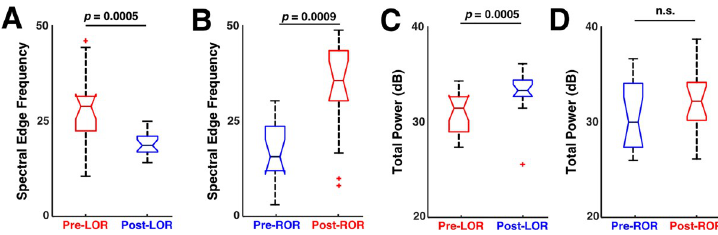
Fig 4. Spectral changes before and after loss and recovery of response. Spectral edge frequency and total power changes that occur in the 20 second clips analyzed before and after loss of response (LOR) and recovery of response (ROR). A) A significant decrease in spectral edge frequency was observed before to after LOR. B) A significant increase in spectral edge frequency was observed before to after ROR. C) A significant increase in total power was observed before to after LOR. D) A decrease in total power was observed before to after ROR. Reported p values are